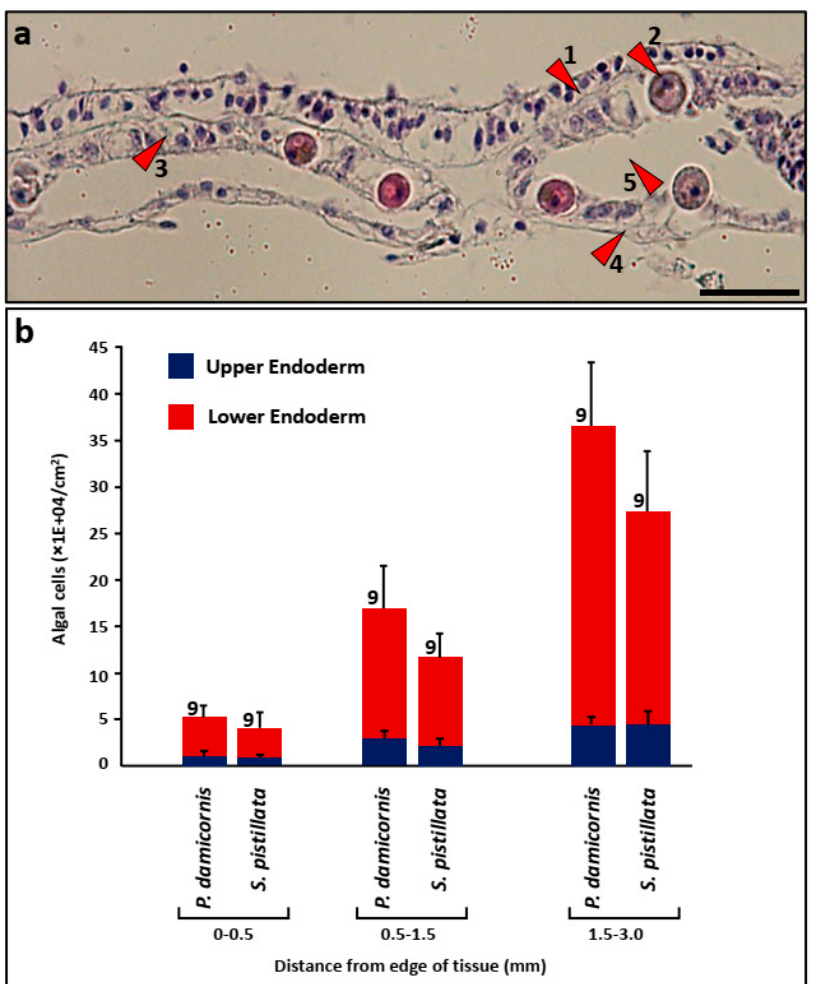
Figure 3. ( a ). A representative histological section of coral tissue spreading on the substratum, with the epidermis (1), endosymbiotic dinoflagellates (2), upper gastroderm (3), the lower gastroderm (4), and part of the ramifying gastrovascular cavity (canal; 5). Scale bar = 20 µ m. ( b ) Zooxanthella numbers